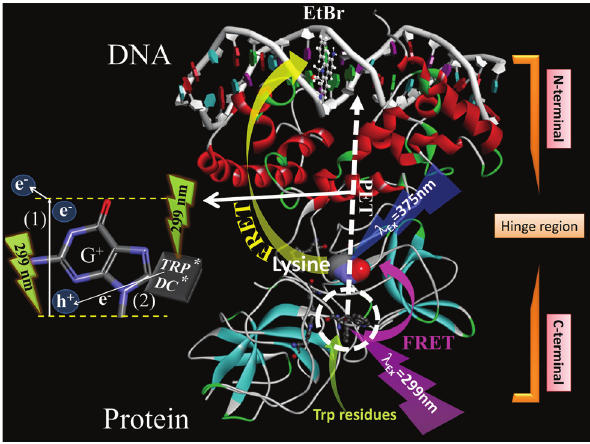
Figure 10 X-ray crystal structure of λ -repressor bound to operator DNA depicting the simultaneous occurrence of Förster resonance energy transfer (FRET) from tryptophan residues to dansyl, bound to lysine near the C-terminal domain, and from dansyl to EtBr, bound to the operator